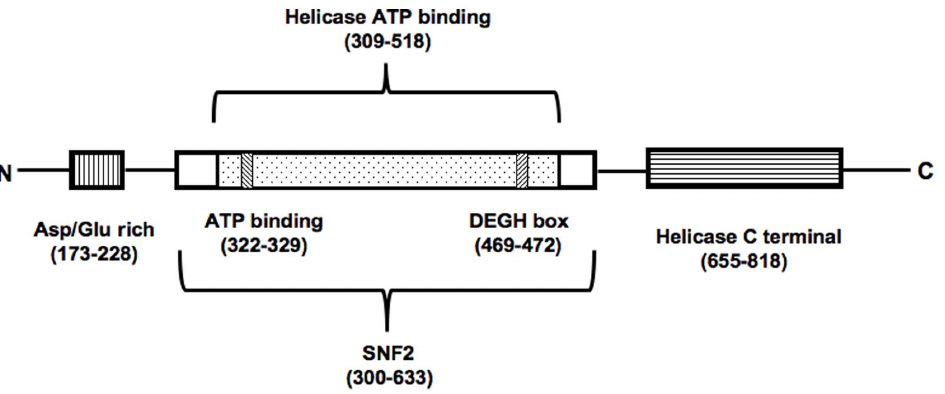
Figure 5. Domain organization of Rad26 protein. Bioinformatics based studies indicated the Rad26 protein to be composed of primarily three distinct domains. The N-terminal aspartate/glutamate-rich acidic domain; a SNF2 domain having the ATP-binding helicase sub-domain consisting of the ATP-binding pocket and a signature DEGH box; and the C-terminal helicase domain.